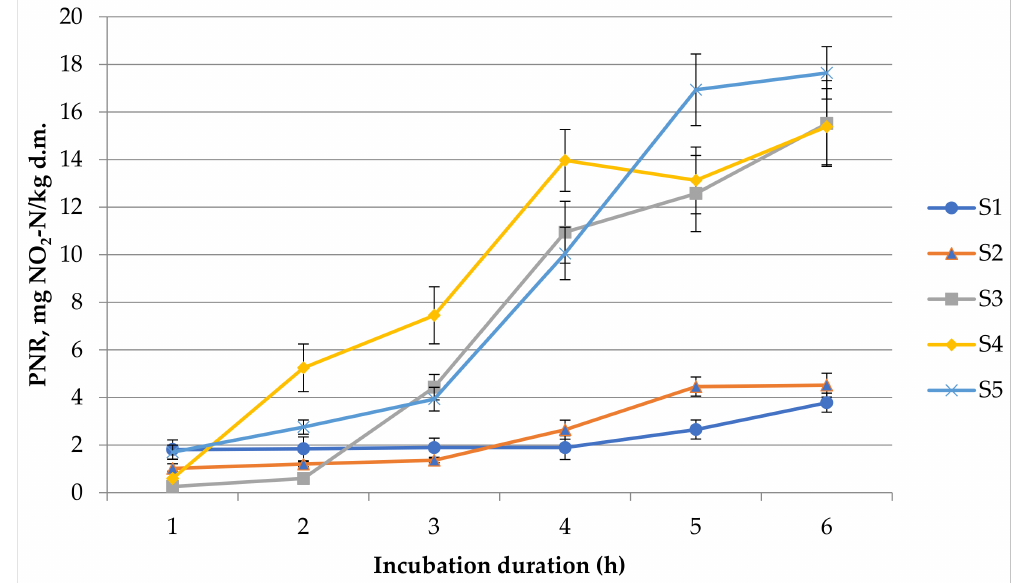
Figure 1. Potential nitrification rates (PNRs) of soil samples (S1, S2, S3, S4, S5) in optimized conditions (20 mL/L NaClO 3